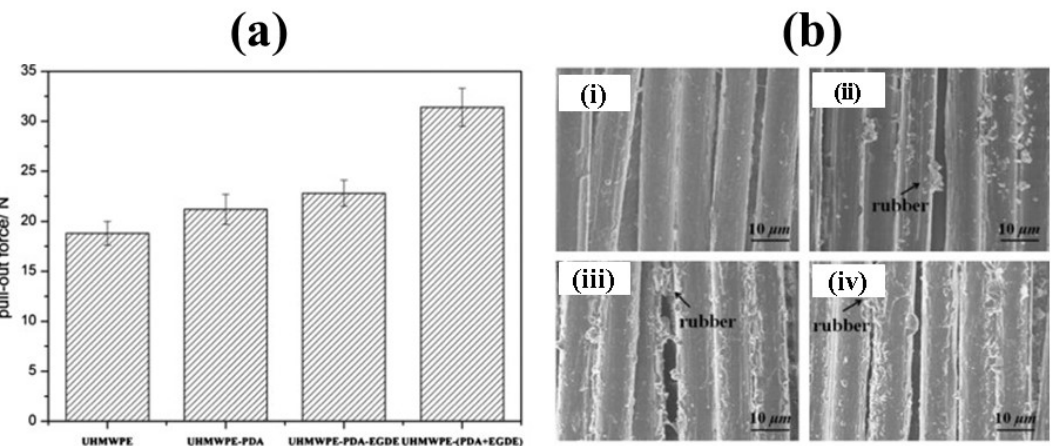
Figure 3. ( a ) Pull out test of UHMWPE and modified fibers; ( b ) SEM images of untreated and treated UHMWPE; (i) UHMWPE fibers/rubber, (ii) UHMWPE–PDA fibers/rubber, (iii) UHMWPE–PDA– EGDE fibers/rubber, and (iv) UHMWPE– (PDA + EGDE) fibers/rubber. Reprinted with permission from [41].